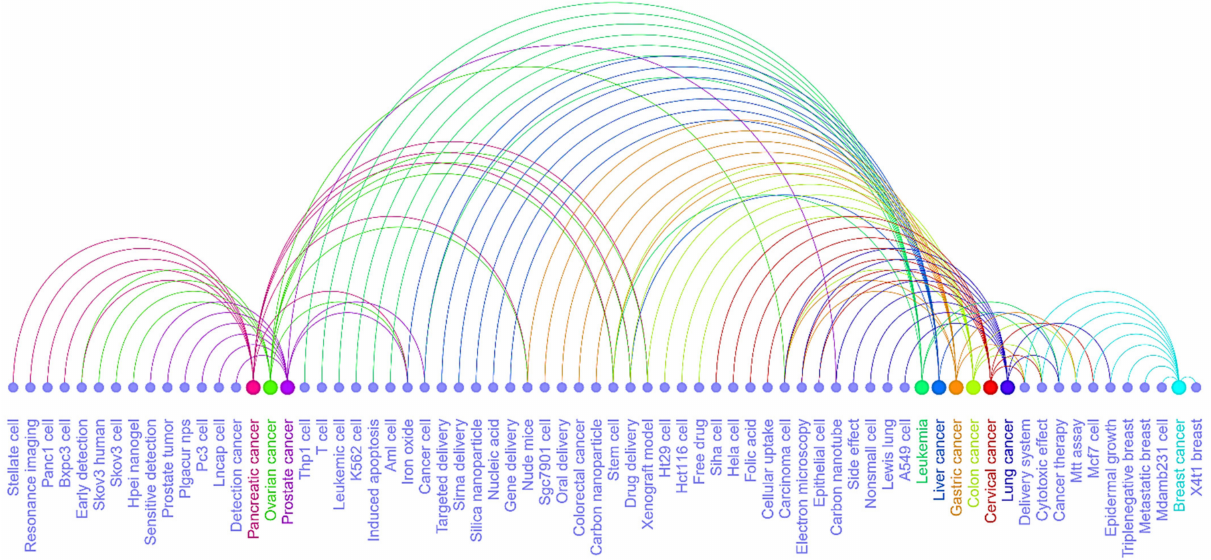
Figure 11. Arc diagram of overlapping research areas among the top 10 cancer types obtained from Figure 10. Large nodes are used to show cancer types and small filled circles represent the top research topics related to each cancer type linked with arc associations. The common topics can be observed by multiple incoming